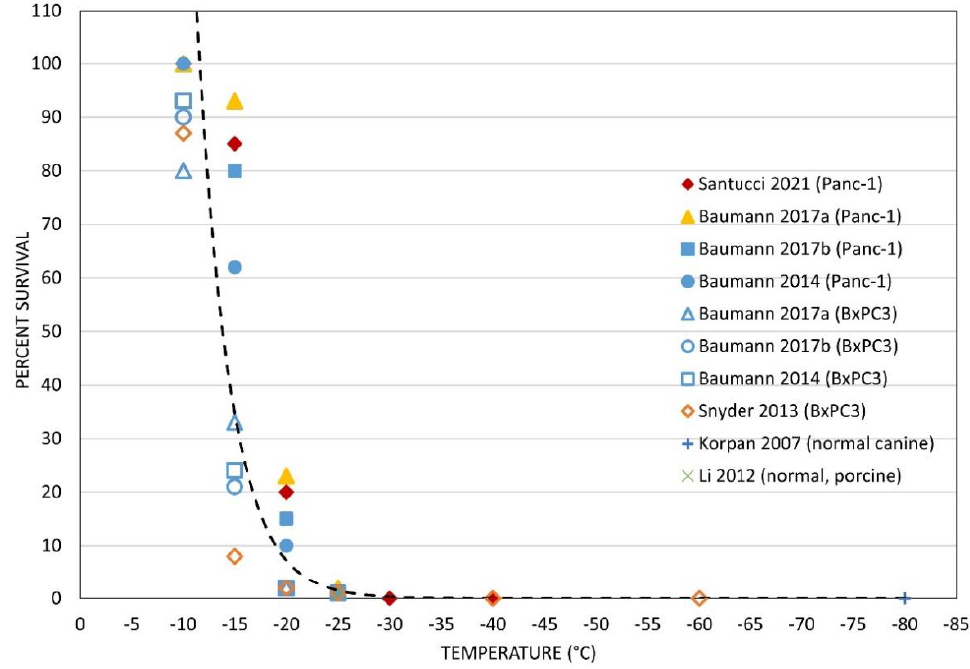
Figure 2. Comparison of the reported level of PaCa cell death following freezing. Data on pancreatic cell death following exposure to various freezing temperatures were collected from the literature and overlaid with specific survival data found following PANC-1 TEM freezing. The TEM data correlated well with previous in vitro and in vivo findings. Trend analysis revealed complete cell death below − 25 ◦ C and a transitional level of cell death between − 15 ◦ C and − 25 ◦ C.